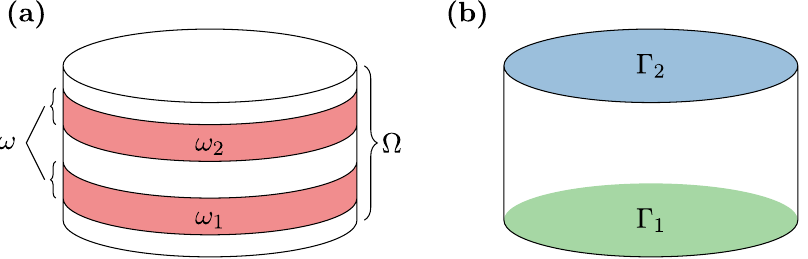
Figure 1. Typical magnetic/nonmagnetic material stack as used for MRAM devices. ( a ) The region ∪ ω ω = ω 1 2 denotes the magnetic material, while Ω denotes the complete sample. ( b ) Electrical contacts Γ 2